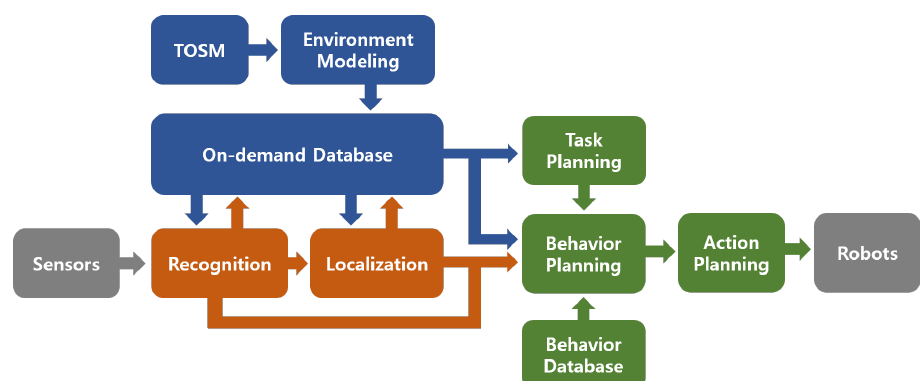
Figure 1. The proposed framework consists of semantic modeling framework (SMF) (blue blocks), semantic information processing (SIP) module (orange blocks), and semantic autonomous navigation (SAN) module (green blocks).